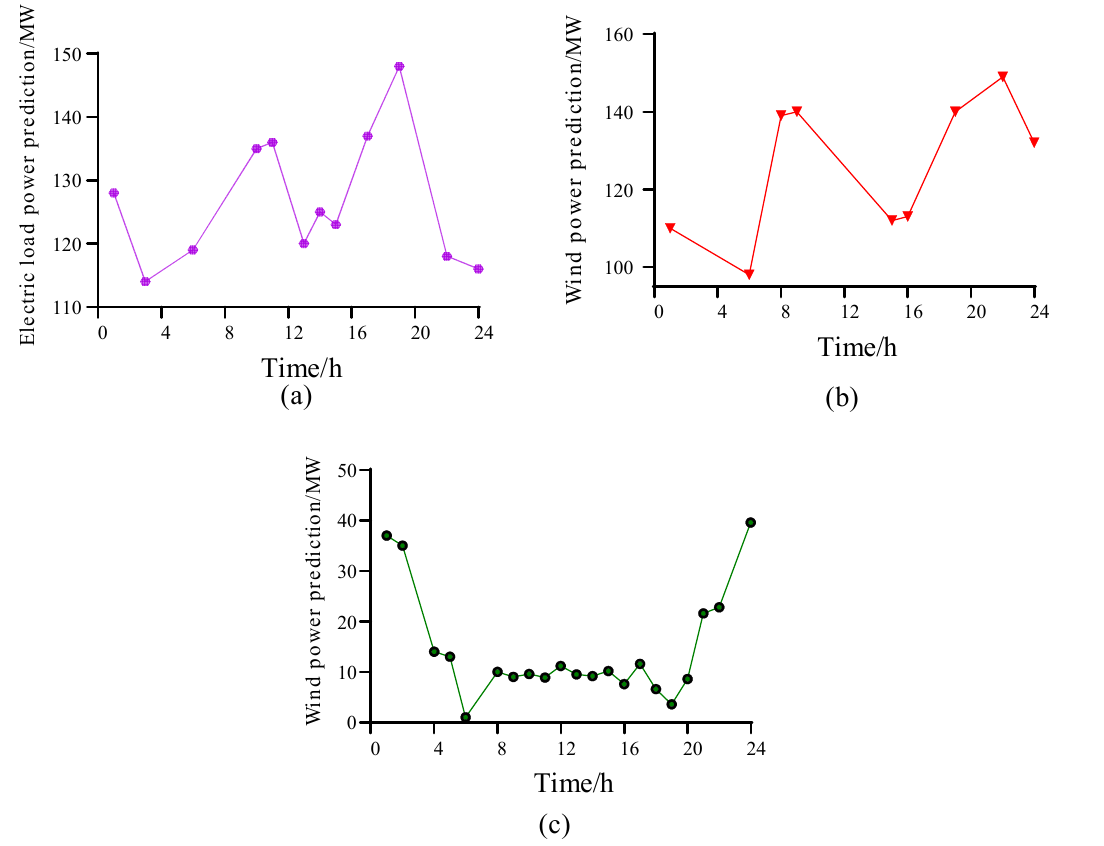
Figure A2. Typical daily load power forecast results ( a ). Electric load power prediction, ( b ). Thermal load power prediction, ( c ). Wind power prediction. Table A2. Forecast error in different periods.